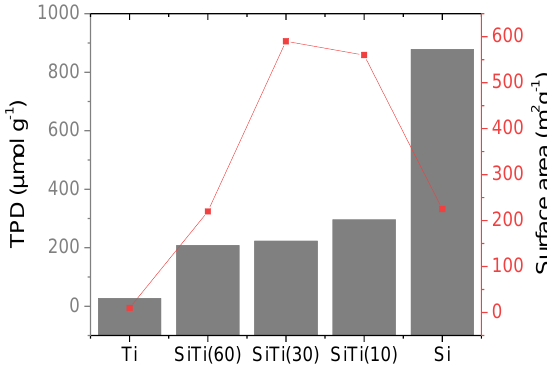
Figure 3. The results of the acidity of the silica and/or titania support materials measured with NH 3 -TPD.